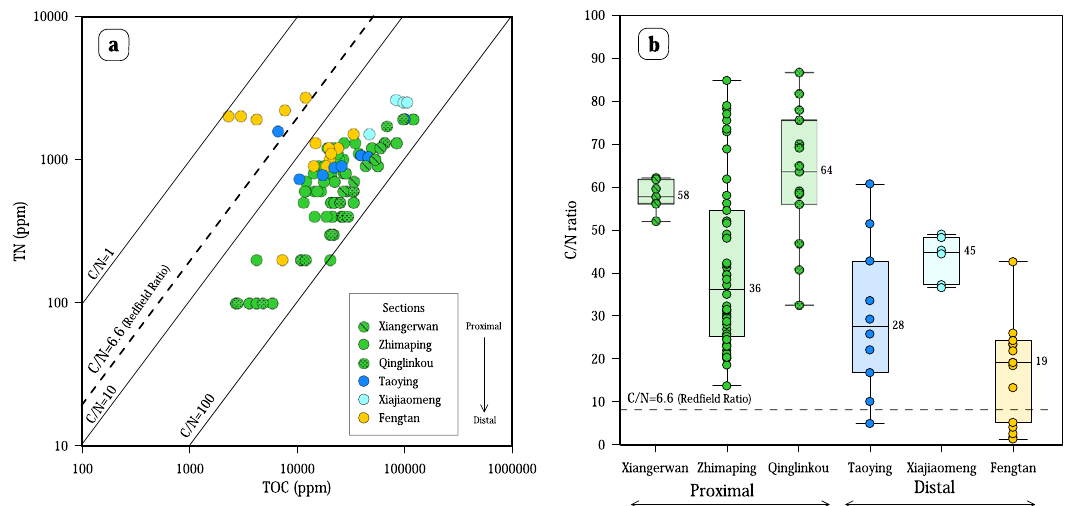
Fig. 2 Measured C and N abundances in the different depositional environments. a C/N ratio presented by stratigraphic sections. The dashed line represents the Red fi eld ratio (C/N = 106/16). b Statistical distribution of C/N ratios from shallow to deep environments showing the full range of ratios (ticked lines), the mean (lines with a number), and one standard deviation distribution